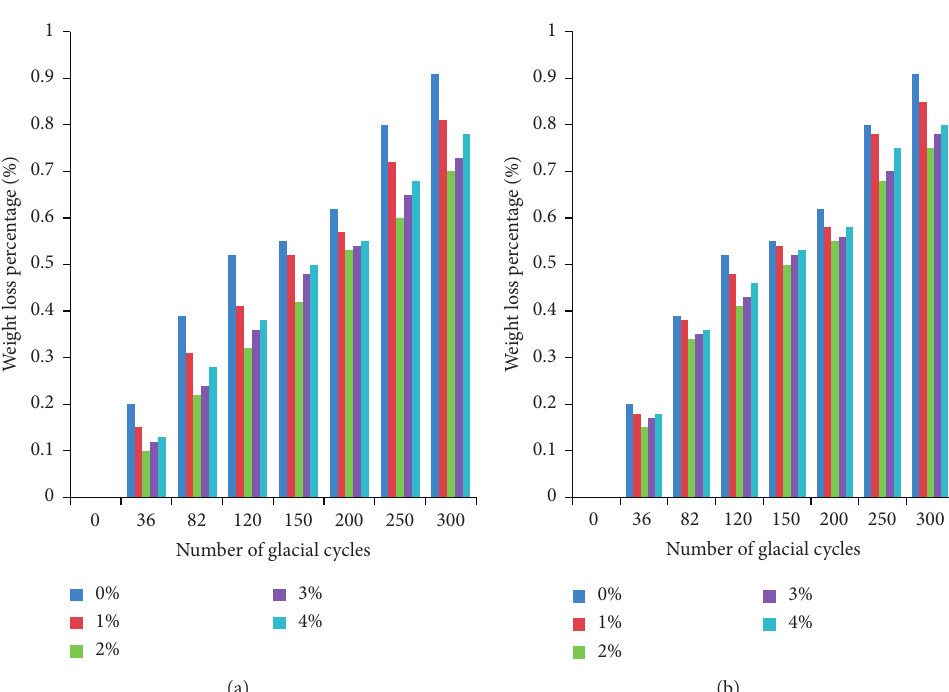
Figure 6: Comparison of weight loss of the concrete samples containing (a) GO/Al